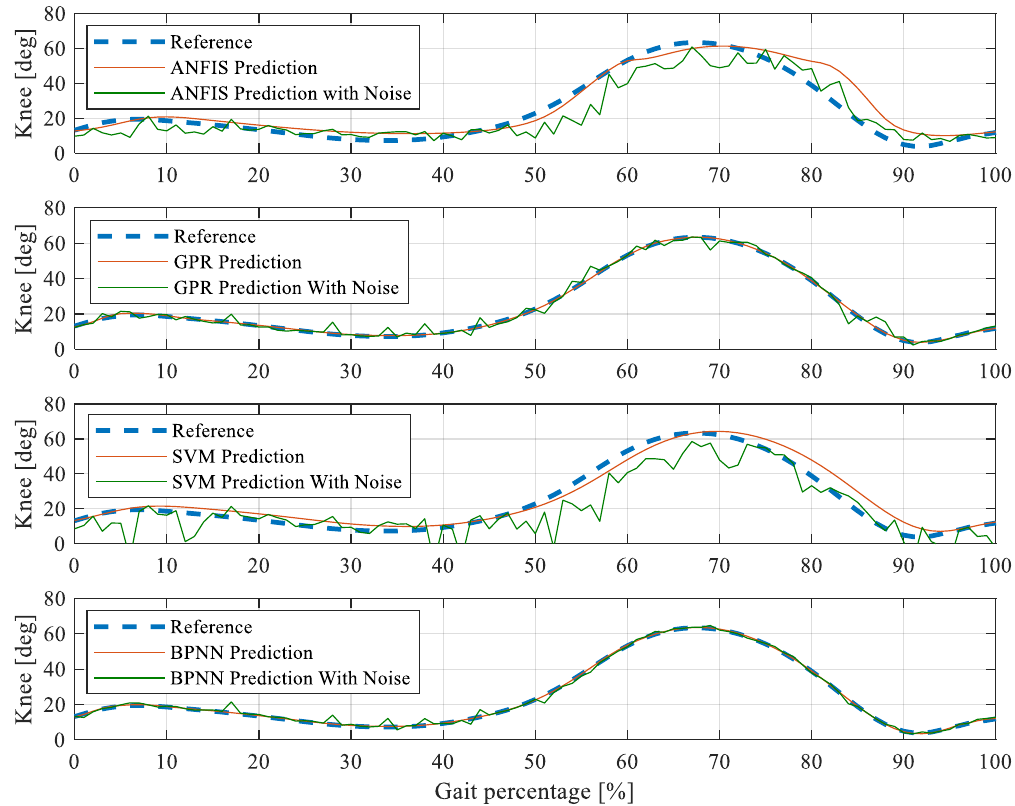
Figure 15. BP neural network gait detection comparison with adaptive network-based fuzzy inference system (ANFIS), gaussian process regression (GPR), and support vector machine (SVM).